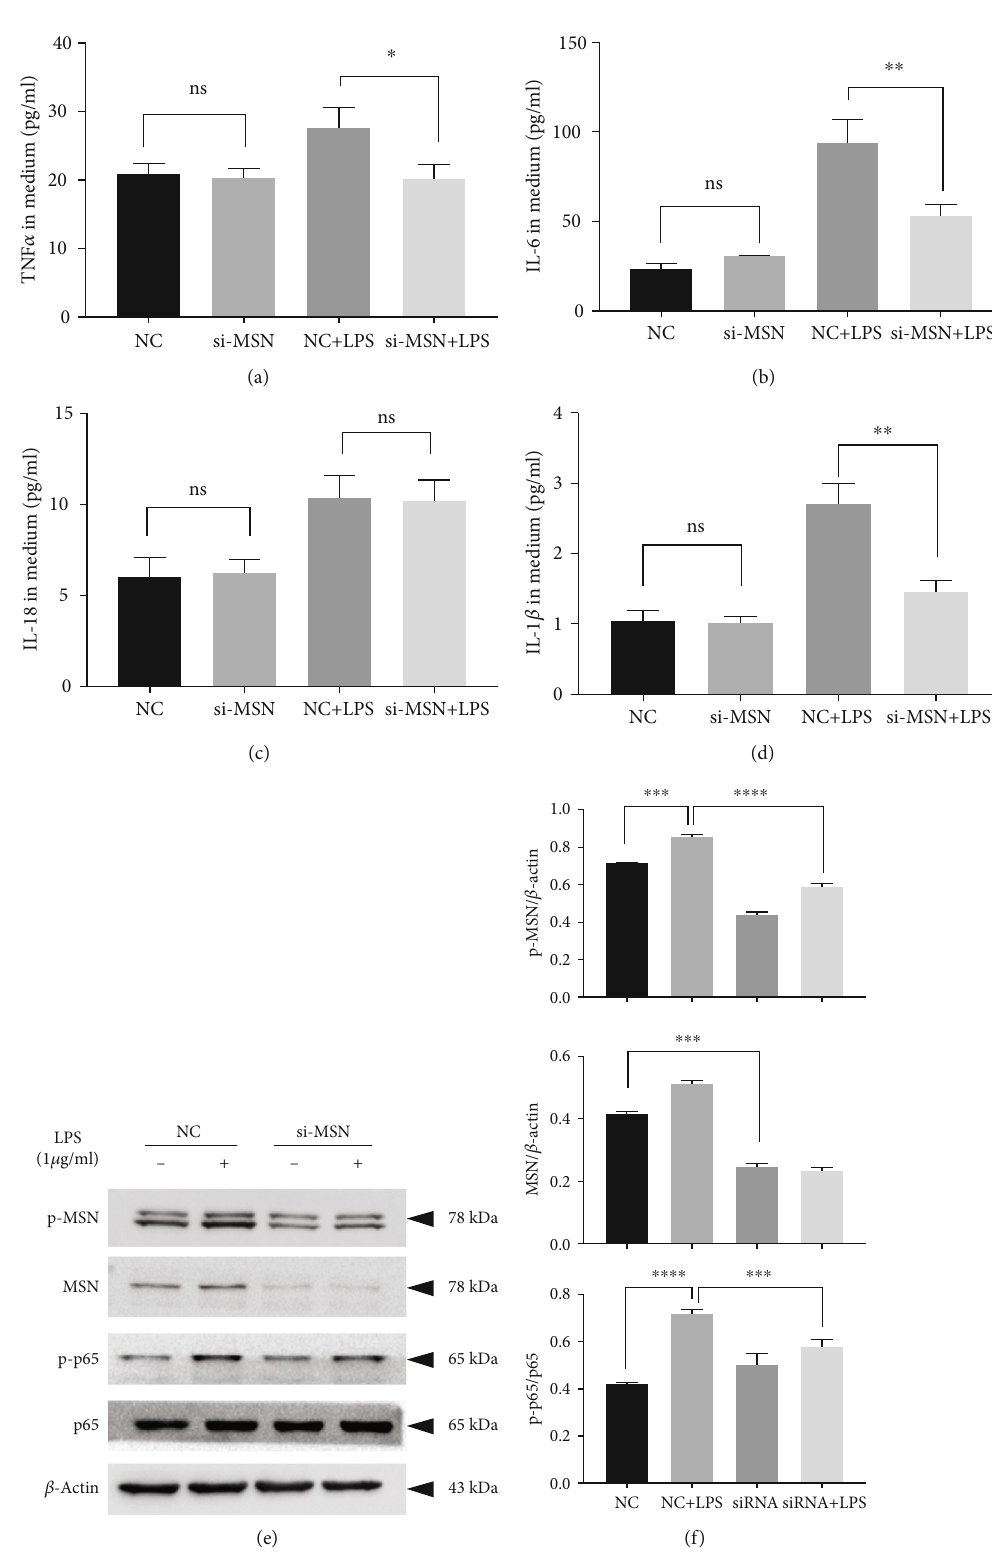
Figure 6: MSN silencing reversed LPS-induced in fl ammatory cytokine production and p65 phosphorylation in HMECs. HMECs were, respectively, transfected with siNC and siMSN RNA for 48 h, then exposed to LPS for 24h, and the supernatants were collected for the ELISA test. MSN silencing reduced the production of TNF- α (a, p < 0 : 05 ), IL-6 (b, p < 0 : 01 ), IL-18 (c, ns), and IL-1 β (d, p < 0 : 01 ) in the medium supernatant of HMECs. In addition, MSN silencing also decreased the expression of phosphorylated p65 increased by LPS (e), and the semiquanti fi cation for WB was shown in